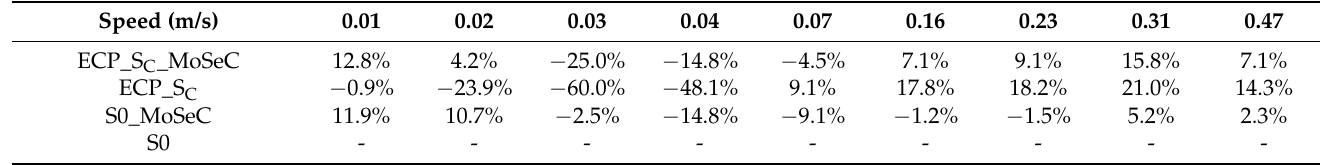
Figure 6. Stribeck curves of S0; S0_MoSeC; ECP_S C and ECP_S C _MoSeC. Table 8. Percentage performance of the S0_MoSeC; ECP_S C ; and ECP_S C _MoSeC specimens in comparison to S0 (positive values are decreases in friction related to the smooth and uncoated specimen while negative values mean increases in